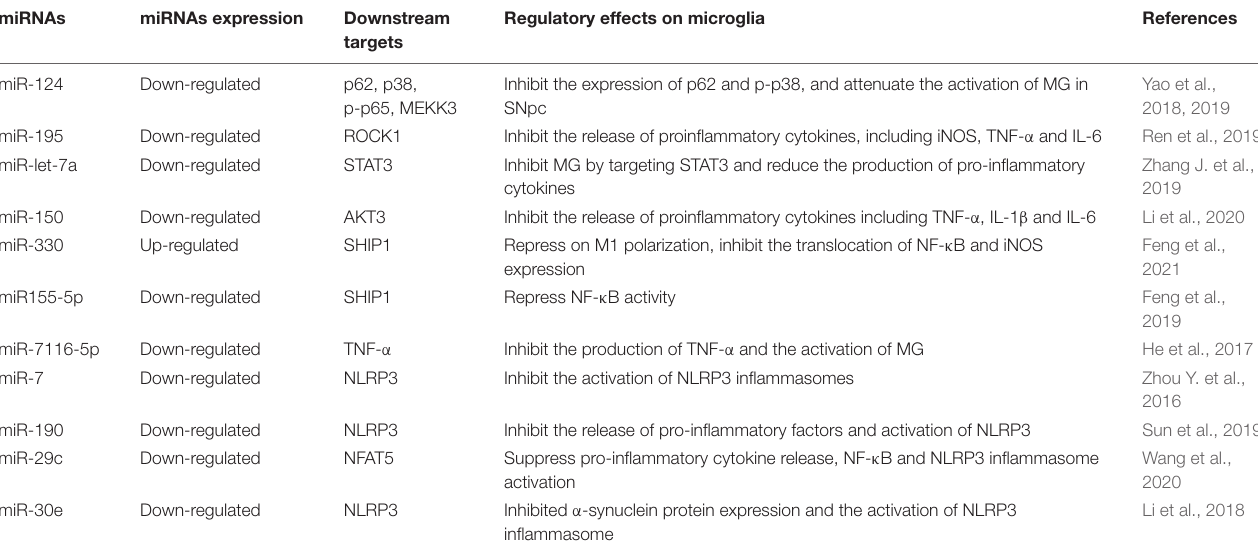
TABLE 1 | MiRNAs regulate microglial function involved in Parkinson’s disease.